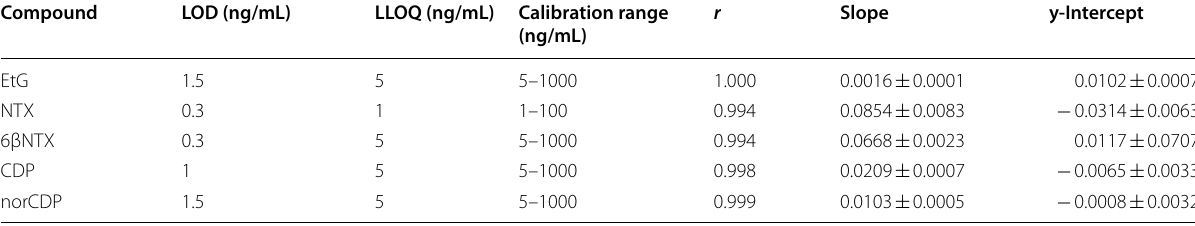
Table 2 Limit of detection (LOD), lower limit of quantification (LLOQ), linearity, and calibration curve Compound